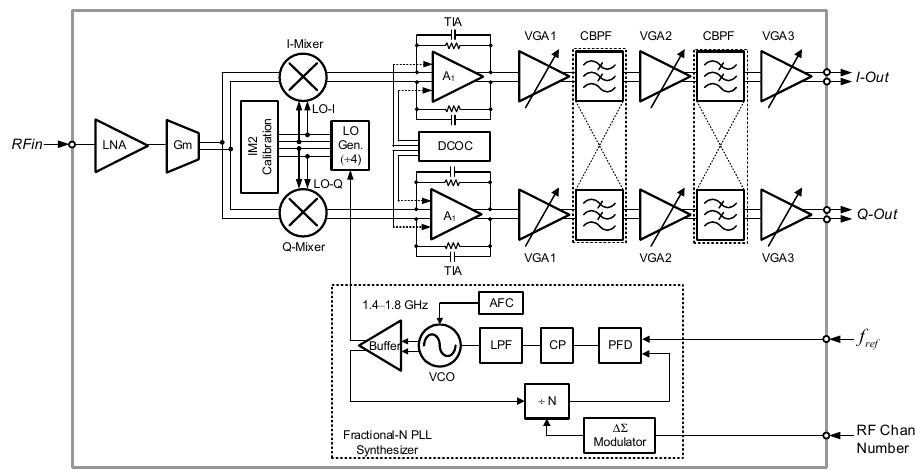
Figure 3. The MedRadio RF receiver architecture.